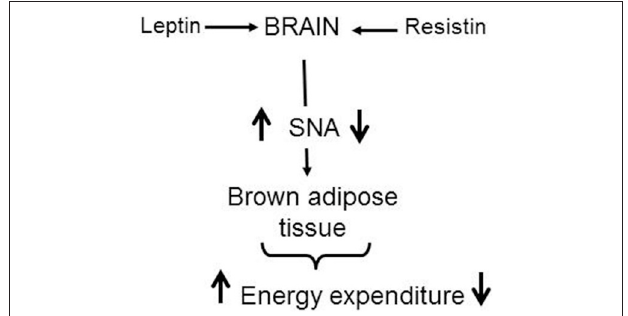
FIGURE 5 | Schematic representation of the central effects of leptin and resistin on sympathetic nerve activity (SNA) to brown adipose tissue. This contributes to changes in energy expenditure. Leptin increases SNA to brown adipose tissue resulting in increased thermogenesis and energy expenditure. In contrast, resistin reduces SNA to brown adipose tissue resulting in a reduction in thermogenesis. In obesity when leptin and resistin levels are elevated, it is tempting to speculate that the interaction with resistin could contribute to the reduced leptin effects observed on SNA to brown adipose